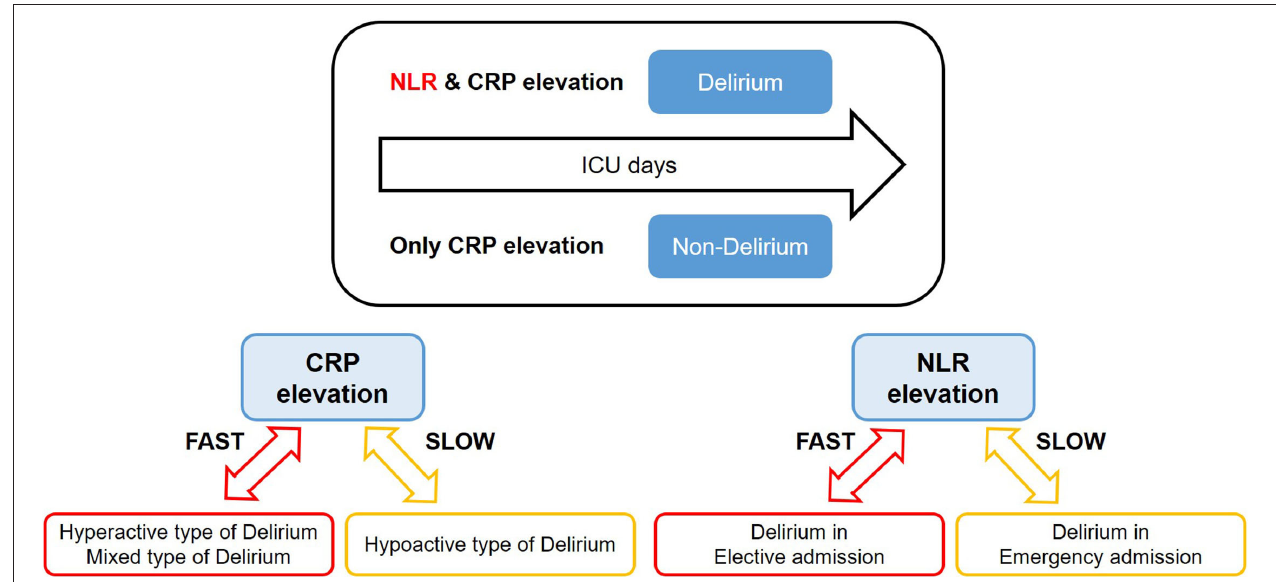
FIGURE 5 | Summary of the study results. NLR, neutrophil-lymphocyte ratio; CRP, C-reactive protein. This figure shows the overall results of our study. Delirium group showed increases in both NLR and CRP over time, while non-delirium group only showed the CRP elevation. Especially, CRP was abruptly increased in delirium patients with non-hypoactive motor subtype compared to the patients with hypoactive motor subtype. NLR was increased fast in delirium patients with elective admission compared to the delirium patients with emergent